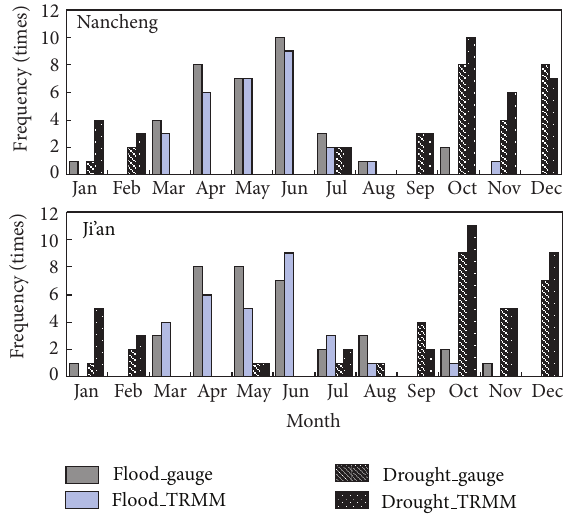
Figure 5: Intra-annual distribution of flood/drought frequency based on TRMM and rain gauges data.